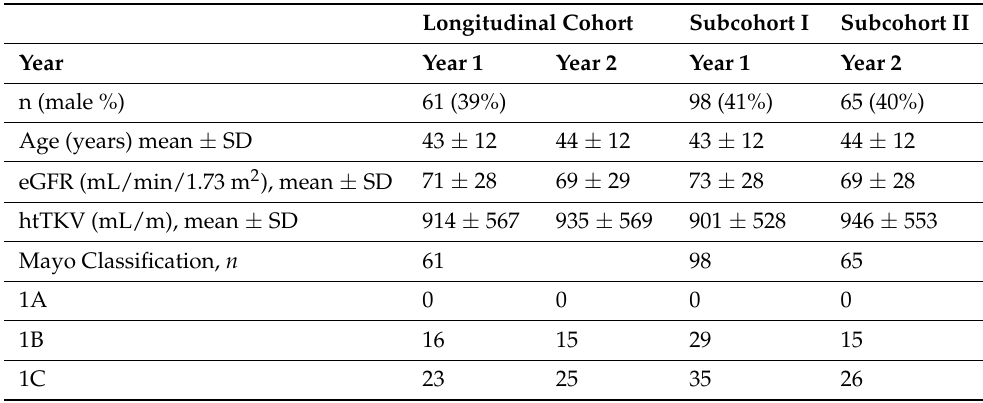
Table 1. Baseline characteristics of the ADPKD cohort. CKD, chronic kidney disease; eGFR, estimated glomerular filtration rate; htTKV, height adjusted total kidney volume; SD, standard